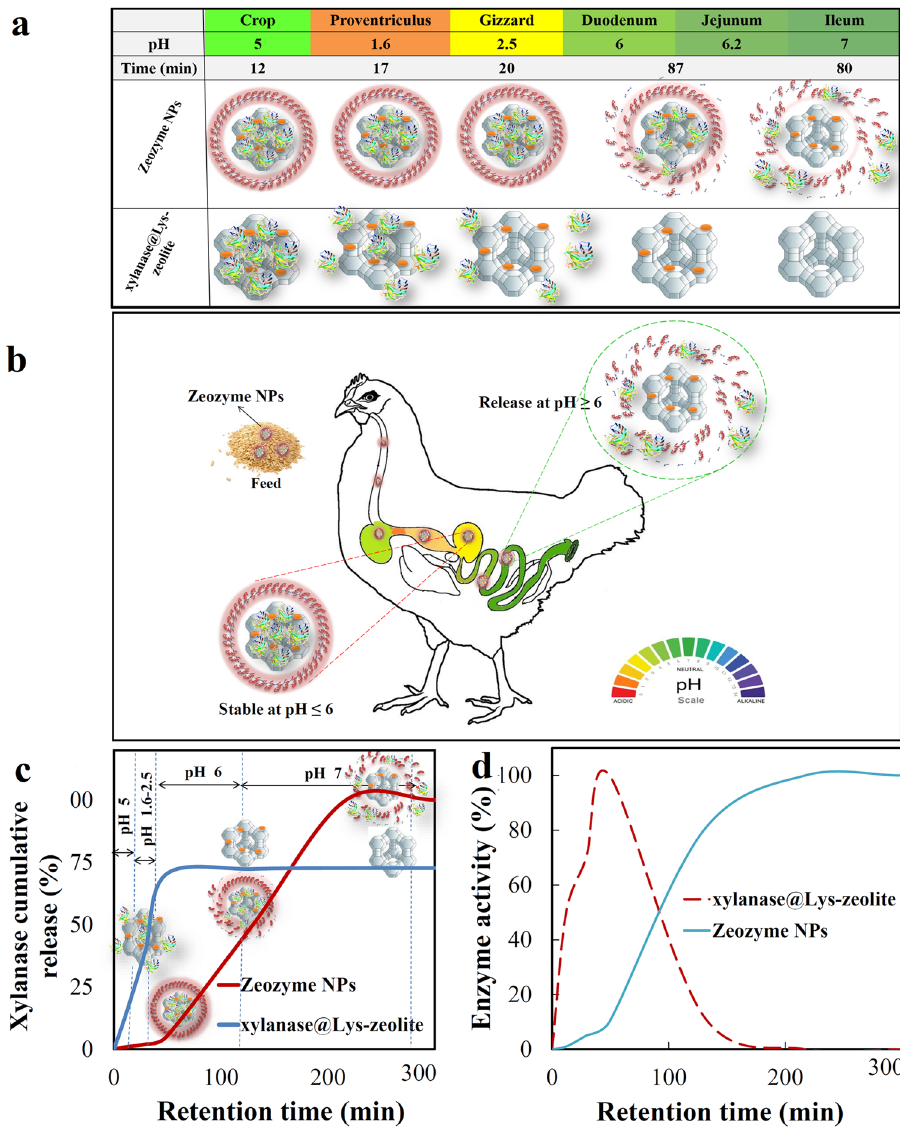
Figure 7. ( a ) Schematic comparison of pattern of release of xylanase from xylanase@Lys-zeolite and Zeozyme NPs in the simulated variable pH conditions and retention time of passage through the GI tract. ( b ) GI tract pH profile of poultry showed by color scale. ( c ) Xylanase cumulative release comparison between xylanase@Lys- zeolite and Zeozyme NPs at 41 °C, where the xylanase release was evaluated by stirring samples at pH 5.2 (for 12 min), pH 1.6 (for 15 min), pH 2.5 (for 20 min), pH 6.0 (for 87 min), and pH 7.1 (for 80 min). ( d ) Enzyme activity of released xylanase comparison between xylanase@Lys-zeolite and Zeozyme NPs at 41 °C based on pH and retention time of